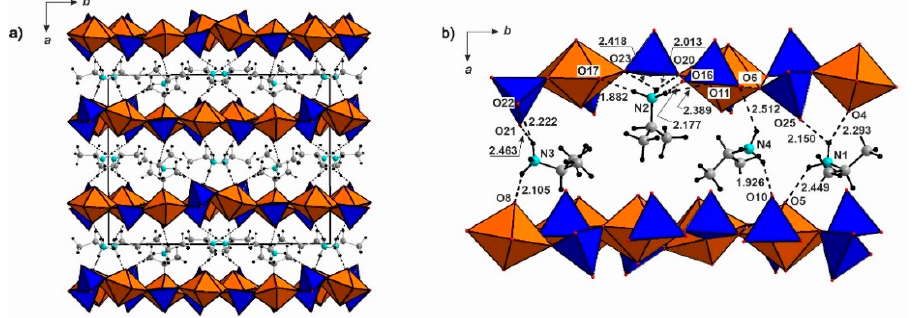
Figure 2. ( a ) General projection of the crystal structure of 1 along the c axis and ( b ) hydrogen bonding with isopropylamine molecules in the interlayer (UO 7 bipyramids = orange, MoO 4 = blue, H = black, C = grey).